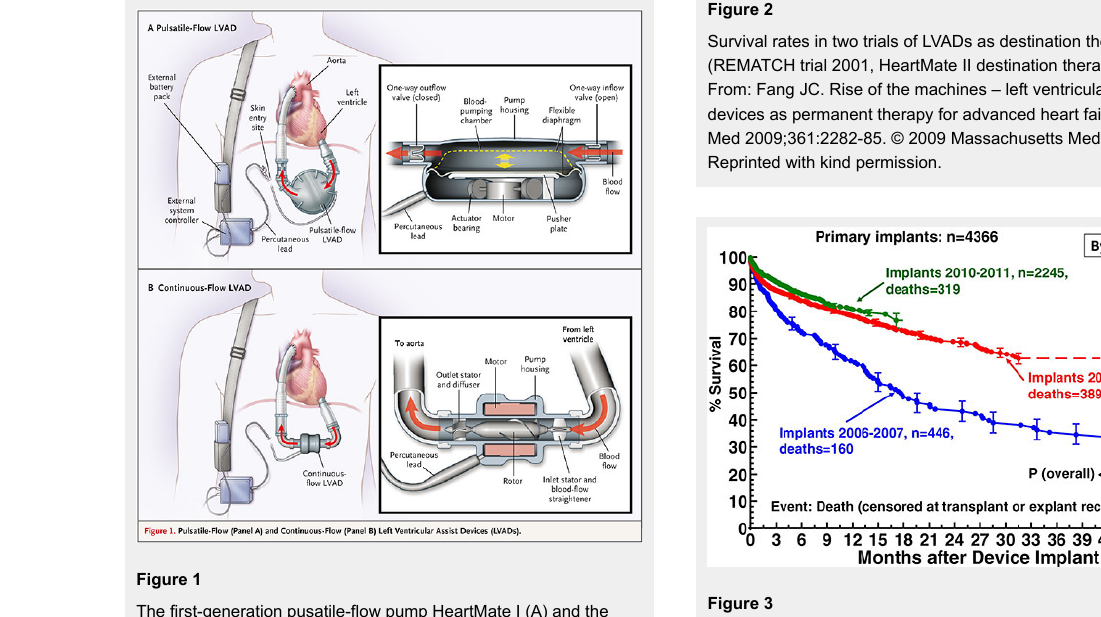
The first-generation pusatile-flow pump HeartMate I (A) and the second-generation continuous-flow pump HeartMate II (B). From: Slaughter MS, Rogers JG, Milano CA, Russell SD, Conte JV, et al. Advanced heart failure treated with continuous-flow left ventricular assist device. N Engl J Med 2009;361:2241-51. © 2009 Massachusetts Medical Society. Reprinted with kind permission.